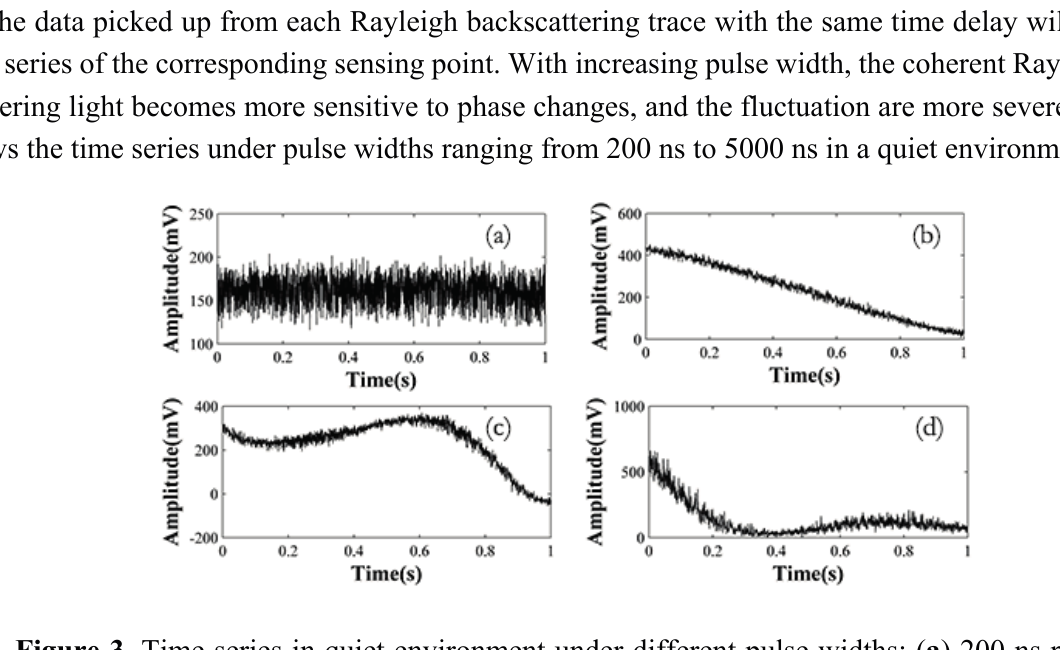
Figure 3. Time series in quiet environment under different pulse widths: ( a ) 200 ns pulse width; ( b ) 1500 ns pulse width; ( c ) 3500 ns pulse width; ( d ) 5000 ns pulse